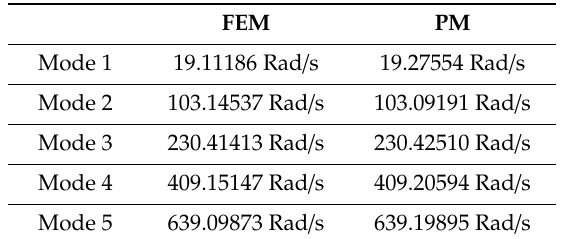
Table 4. Comparison of natural frequencies obtained by the FEM and the proposed mathematical method.